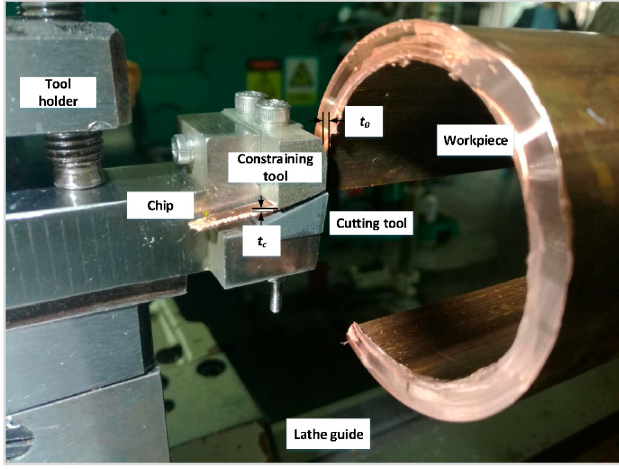
Figure 2. Setup for LSEM.